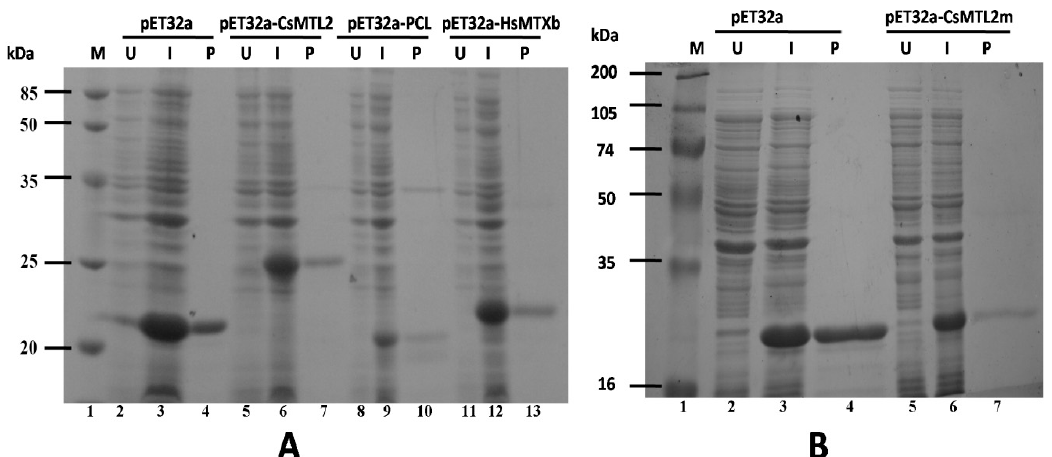
Figure 4. Sodium dodecyl sulfate ‐ polyacrylamide gel electrophoresis (SDS ‐ PAGE) analysis of Trx ‐